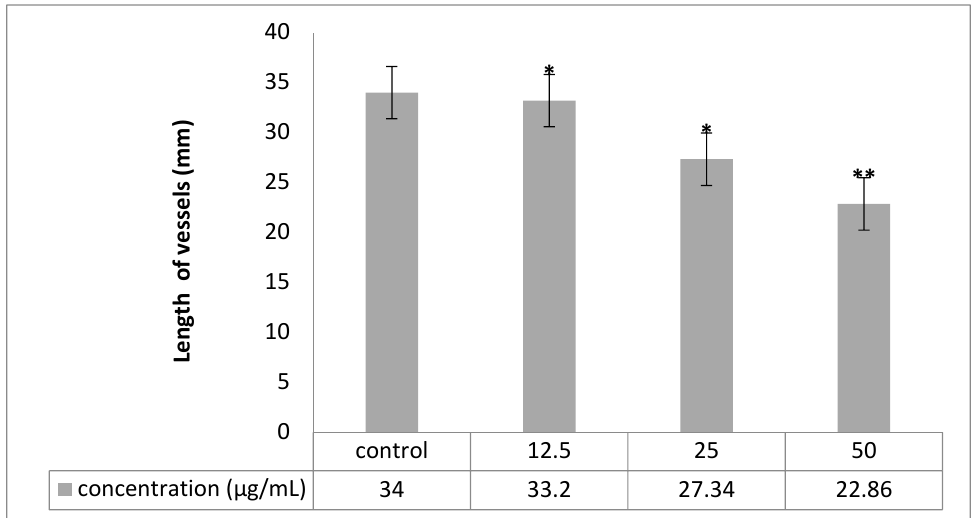
Figure 9. Comparison of length of new vessels in four groups. Treated groups compared with control group (* p < 0.05, ** p < 0.001).